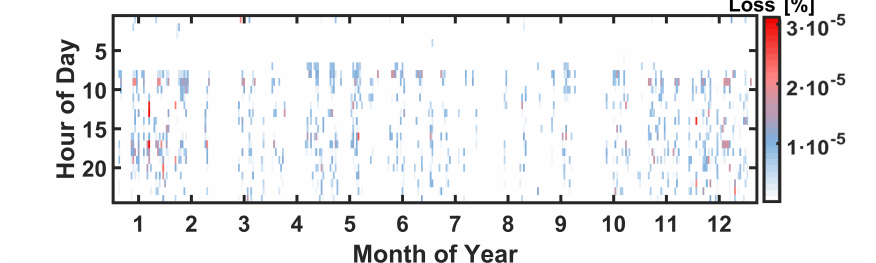
Figure 25. Hourly mean total loss increment for Scheme 3